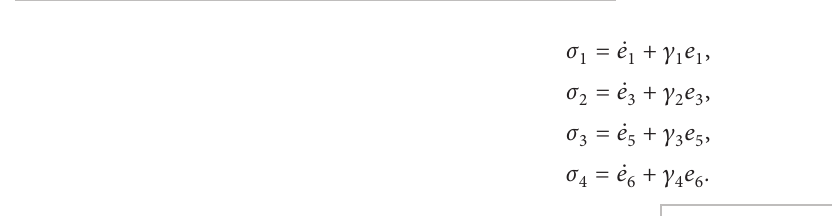
( t ) and y ( t ) versus time. (d) The states x 7 7